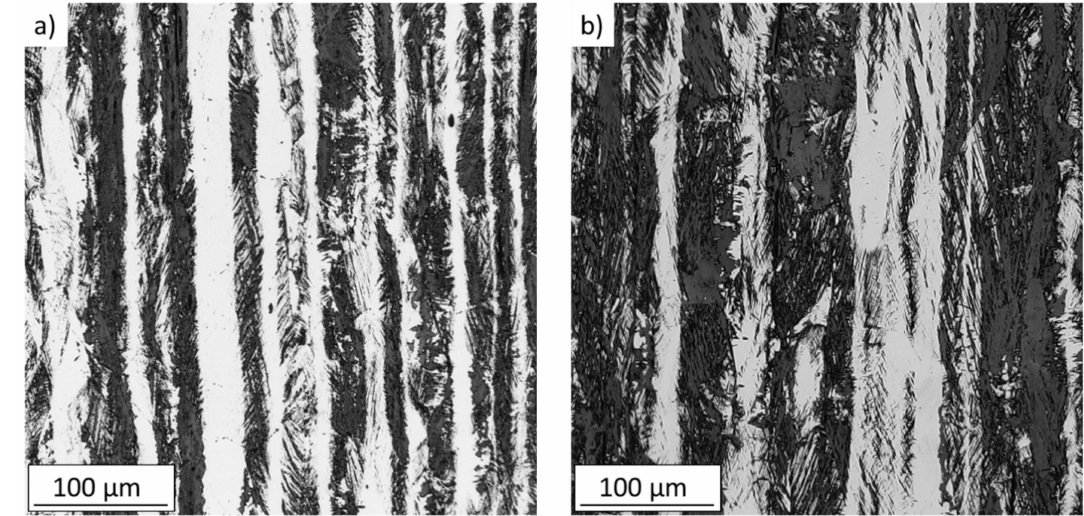
Figure 4. Microstructure of the tensile test specimens gauge lengths; the dark areas correspond to strain-induced α ’- martensite, ( a ) as-received state, ( b ) solution-annealed